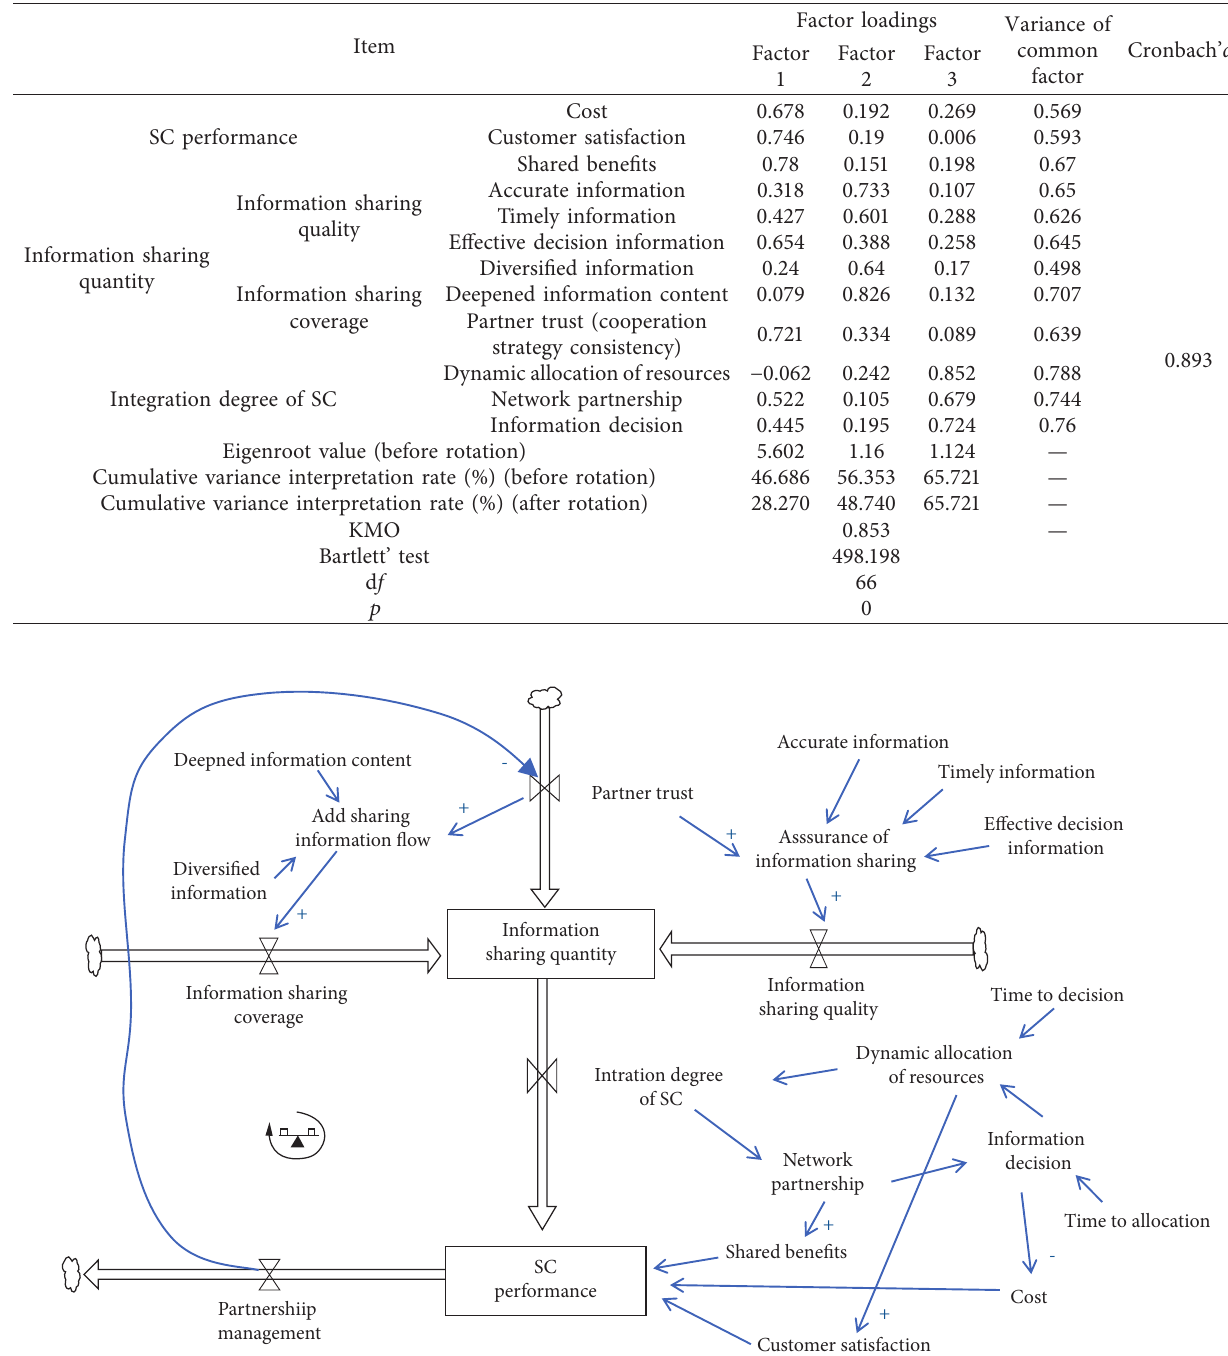
Table 1: The validity and reliability.